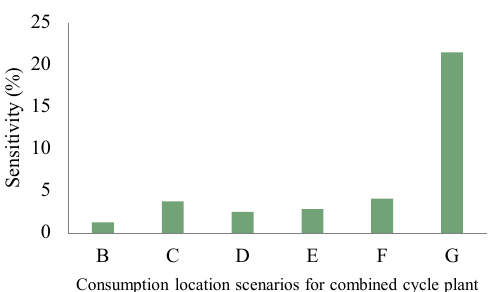
Fig. 9: Scenarios for internal consumption of the combined cycle power plant